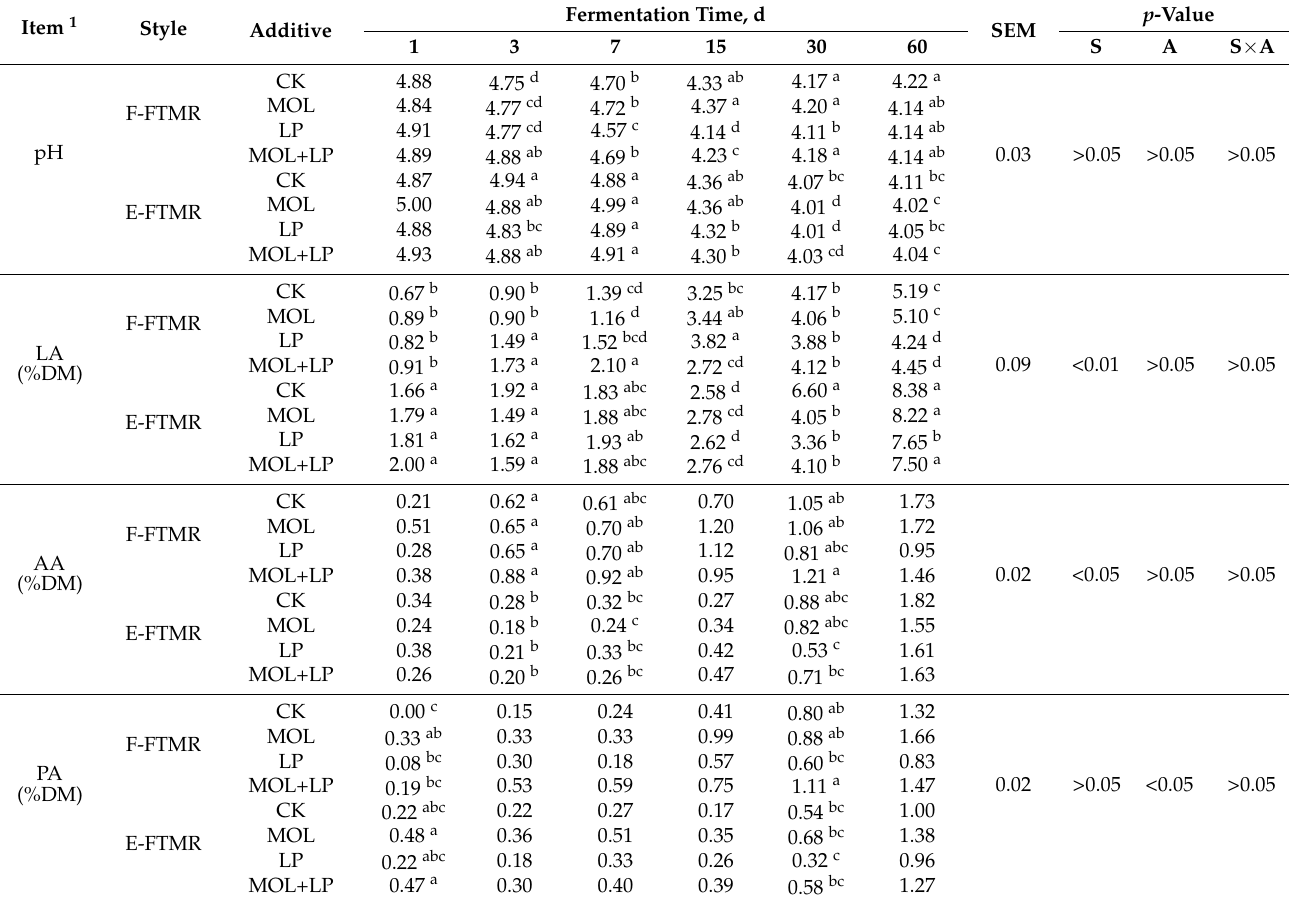
Table 5. The dynamics fermentation characteristics of fresh-alfalfa and ensiled-alfalfa FTMR after